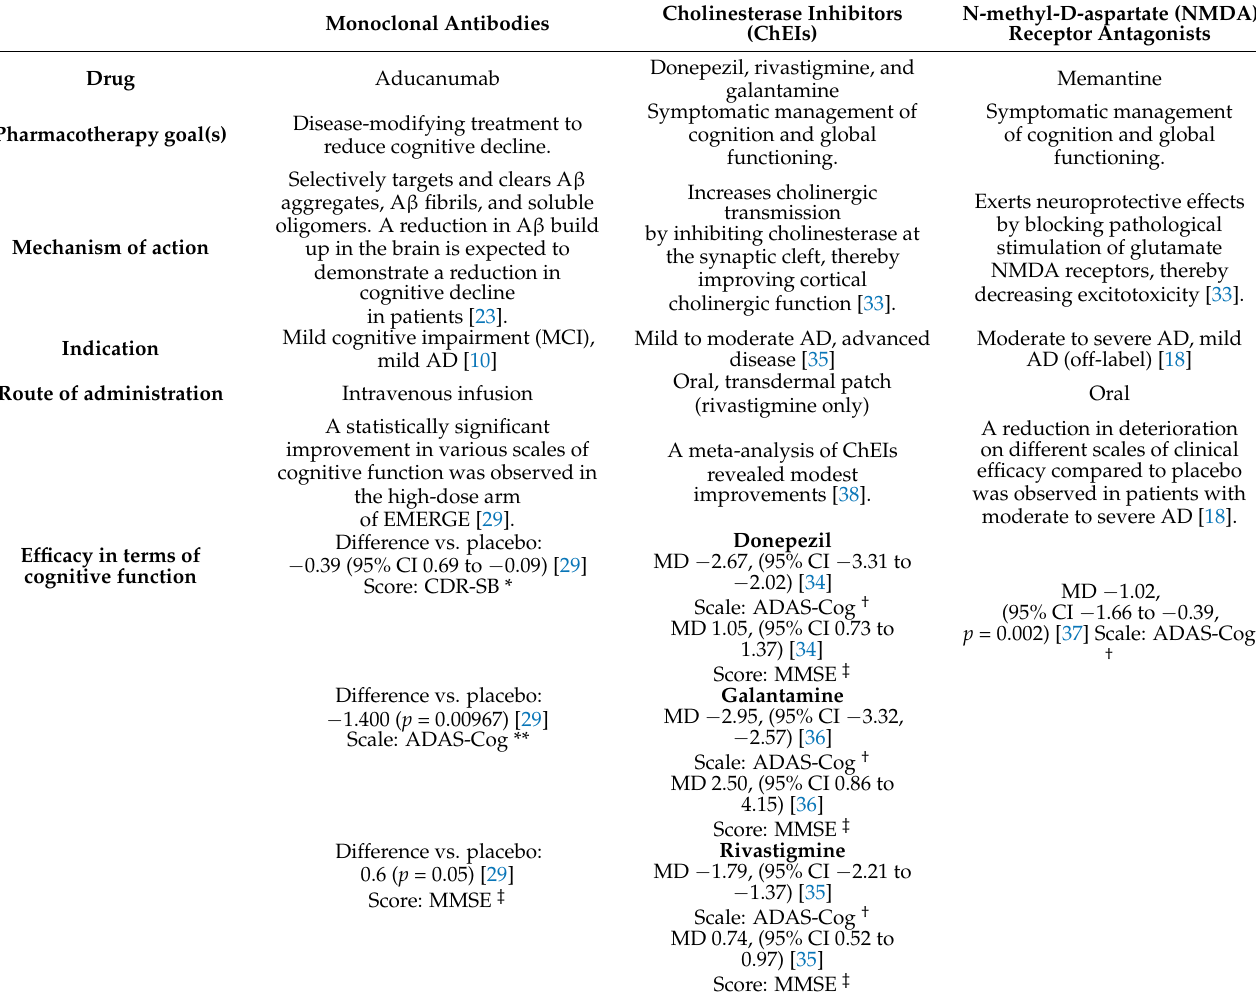
Table 1. Direct comparison between aducanumab and mainstay pharmacotherapy of AD. Cholinesterase Inhibitors N-methyl-D-aspartate (NMDA) Monoclonal Antibodies (ChEIs) Receptor Antagonists Donepezil, rivastigmine, and Aducanumab galantamine